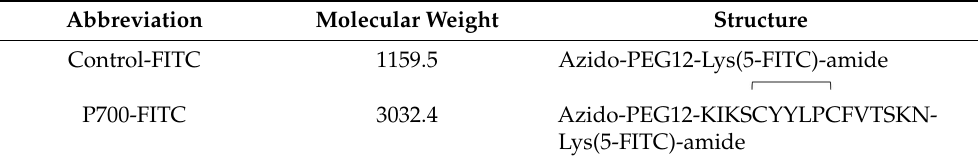
Table 1. Structure of p700-FITC and control